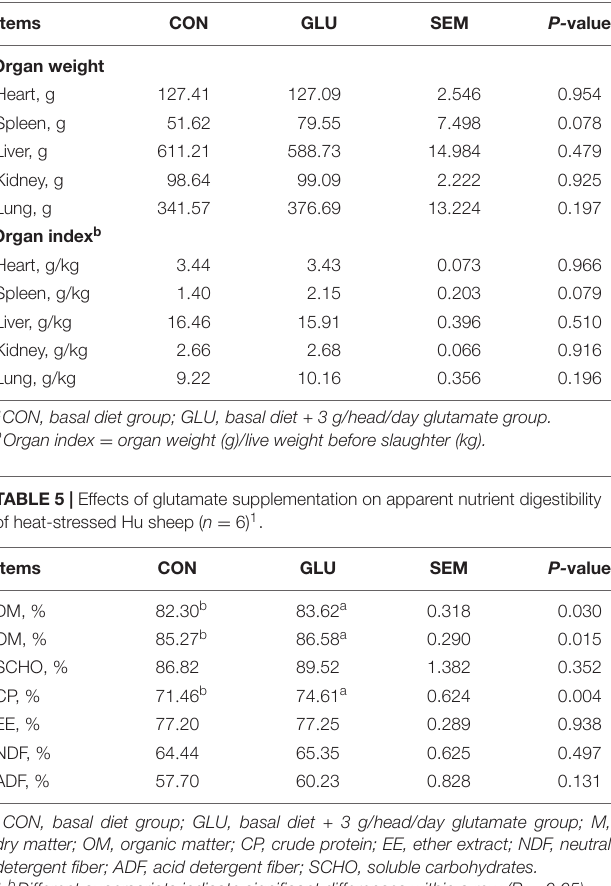
TABLE 4 | Effects of glutamate supplementation on organ index of heat-stressed Hu sheep ( n = 6) a . Items CON GLU SEM P- value